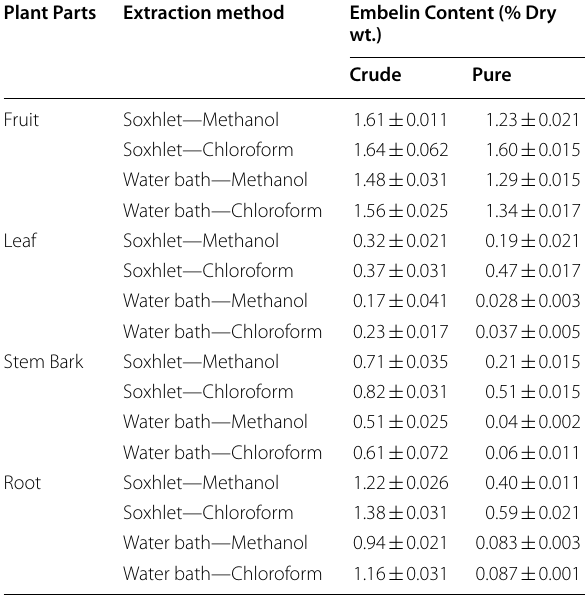
NB-Data are expressed as mean